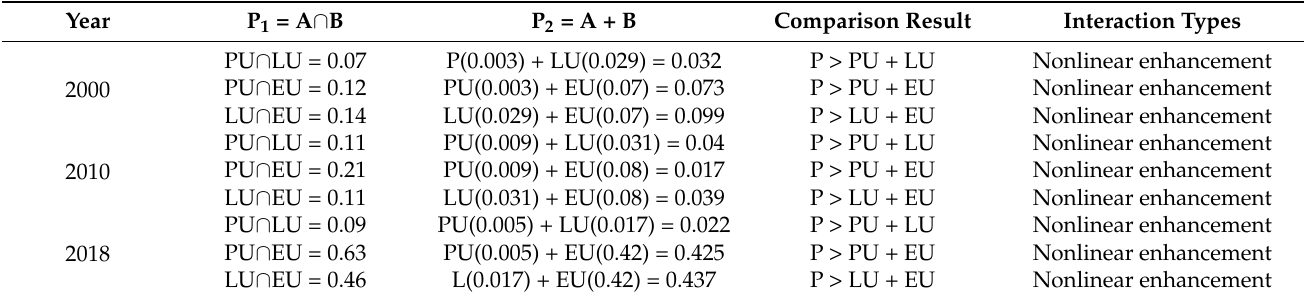
Table 6. The interaction effect of multi-dimensional urbanization factor on PM 2.5